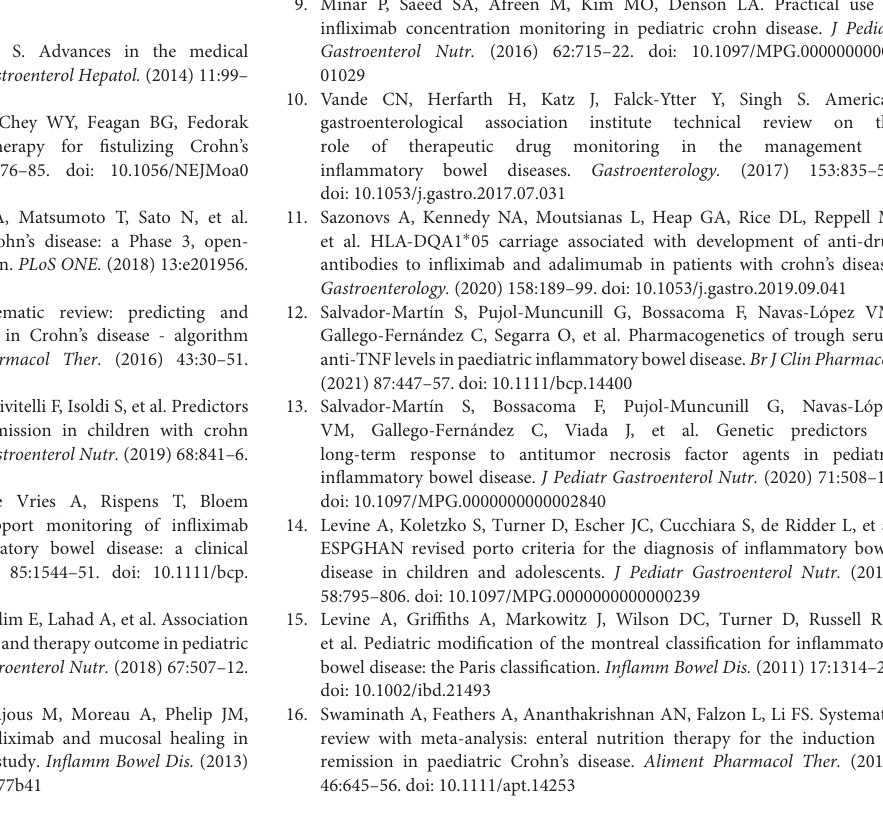
Supplementary Figure S1 | Illustration of infliximab therapeutic protocol for pediatric CD patients at our center. IFX, infliximab; EEN, exclusive enteral nutrition; TDM, Therapeutic drug